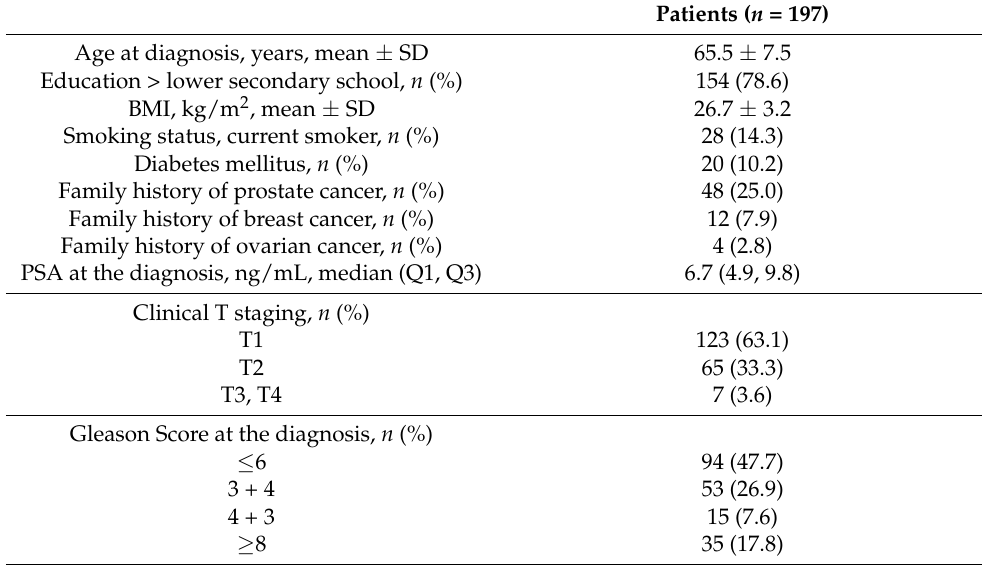
Table 1. General characteristics of the patients included in the Pros-IT2 study.